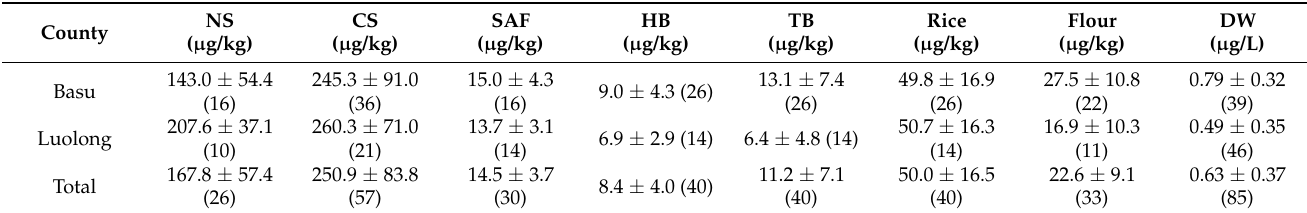
Table 2. Se contents of environmental samples in the study area (mean ± SD).